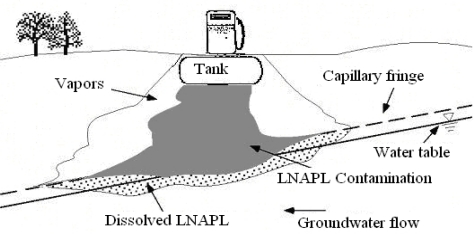
LNAPLs release and subsequent migration [4].